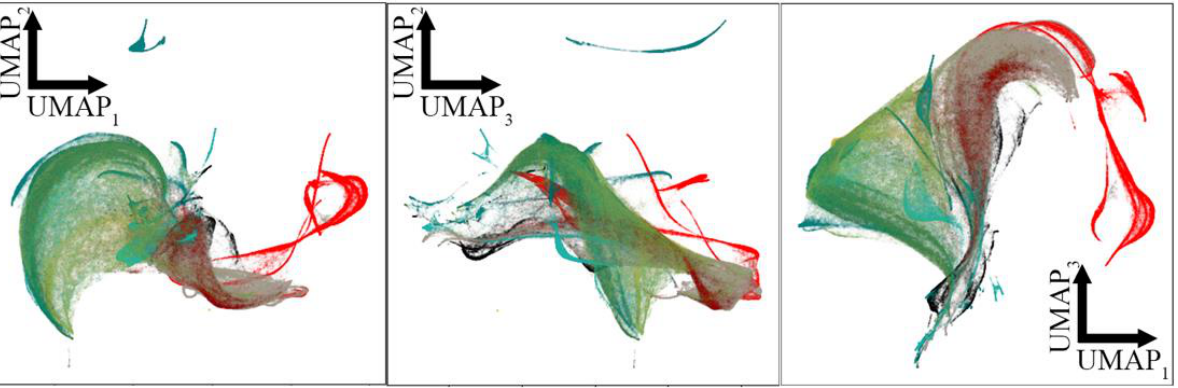
Figure A3. UMAP results using a 3D embedding space. This figure uses min_dist = 0.1, 30 nearest neighbors, and Euclidean distance metric.